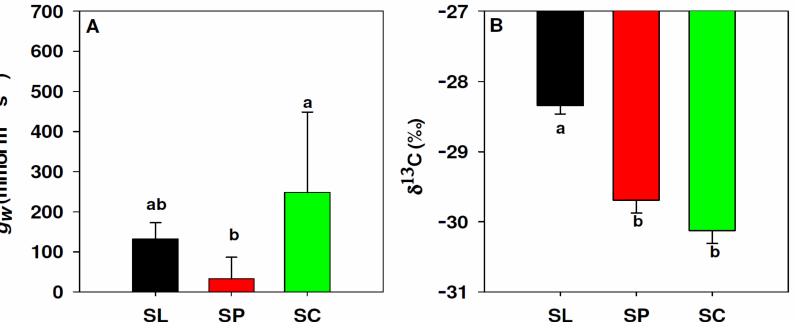
Figure 4. Differences in leaf conductance to water vapour, gw ( A ) and leaf isotope composition of 13 C, δ 13 C ( B ) between S. lycopersicum (black, SL), S. peruvianum (red, SP) and S. chilense (green, SC). Values in ( A ) represent the median and 75% percentile. Values in ( B ) represent the mean and standard error. Letters indicate significant differences ( p < 0.05) according to Fisher ( B ) and Dunn’s ( A ) tests.